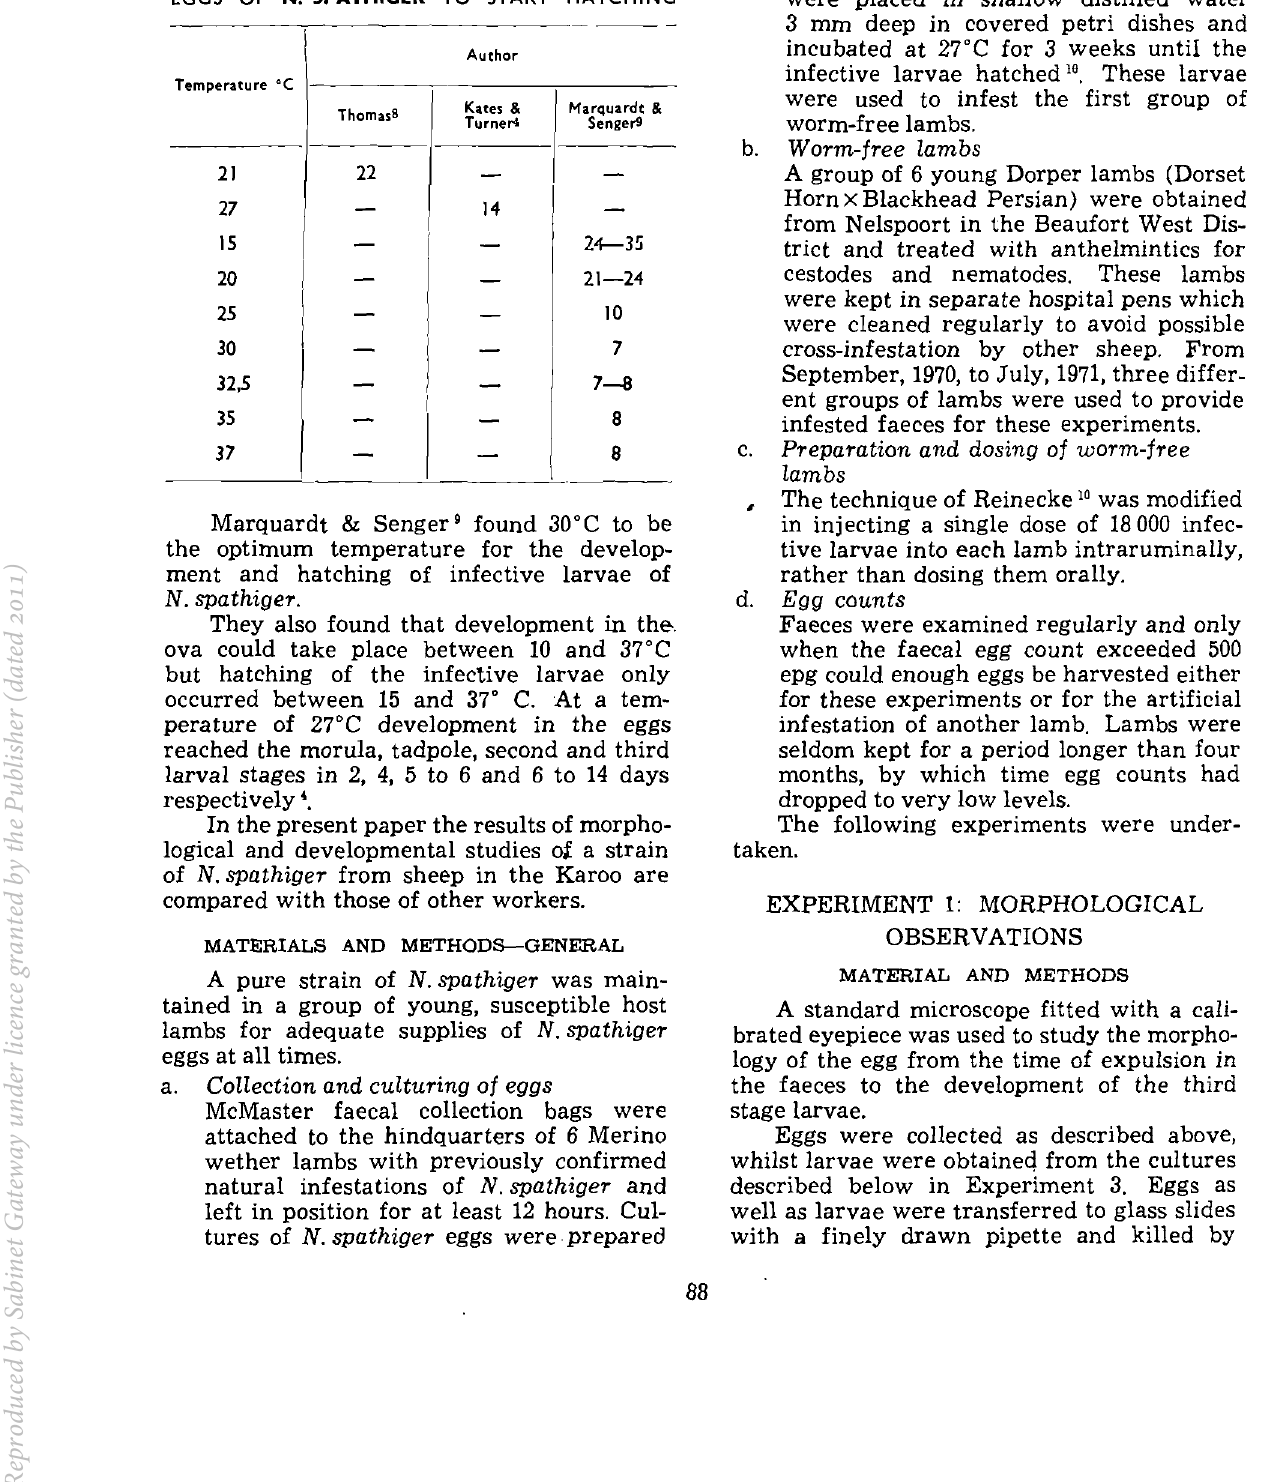
Table 2: NUMBER OF DAYS REQUIRED FOR THE EGGS OF N. SPATHIGER TO START HATCHING